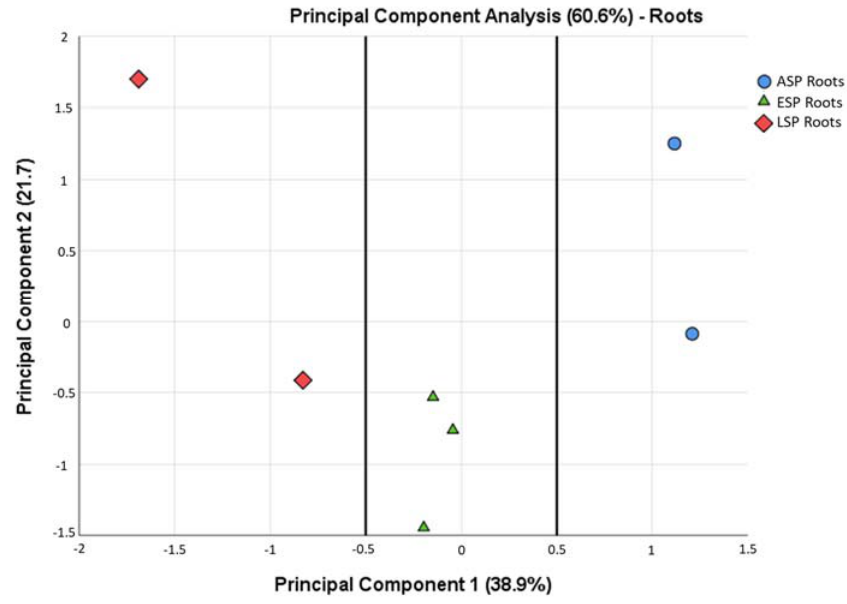
Figure 10. Principal Component Analysis calculated among the root samples, based on the relative abundance of OTUs in each family. The lines were added to highlight the separation between the ASP root samples, the ESP root samples, and the LSP root samples.